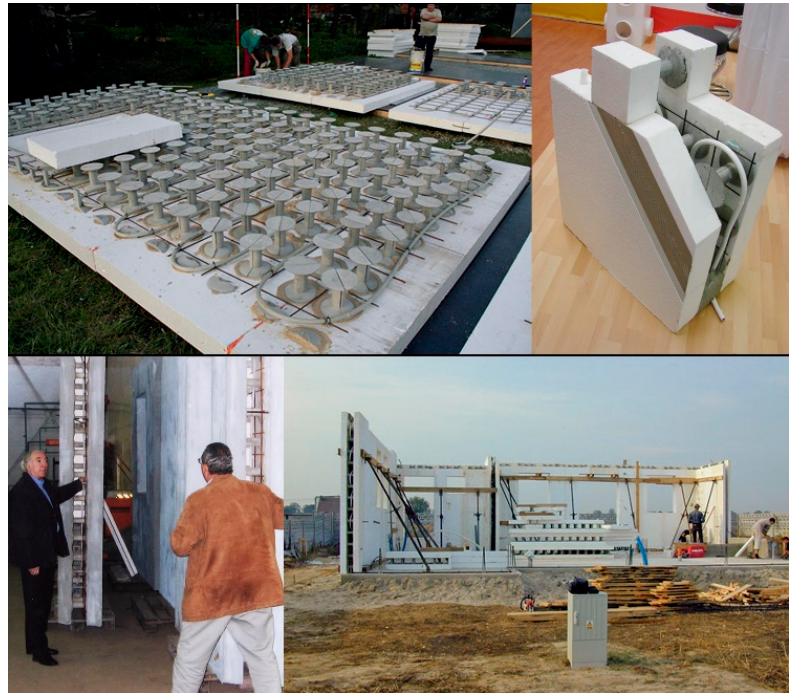
Figure 4. Thermal barrier embedded in the load-bearing part of reinforced concrete panels bounded on the interior and exterior side by thermal insulation [1,2].